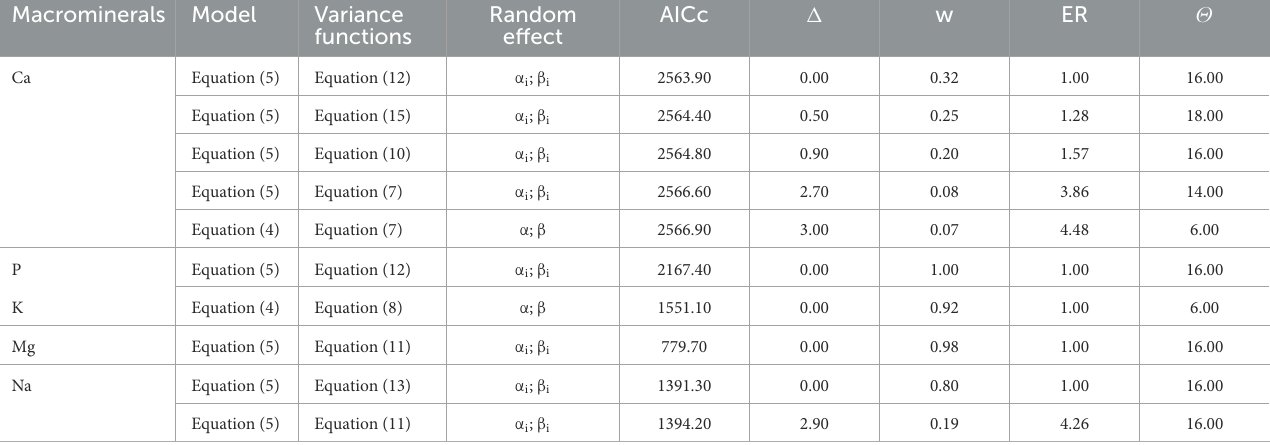
TABLE 5 Information criteria of fitted models to estimate the net requirements for gain of hair sheep.